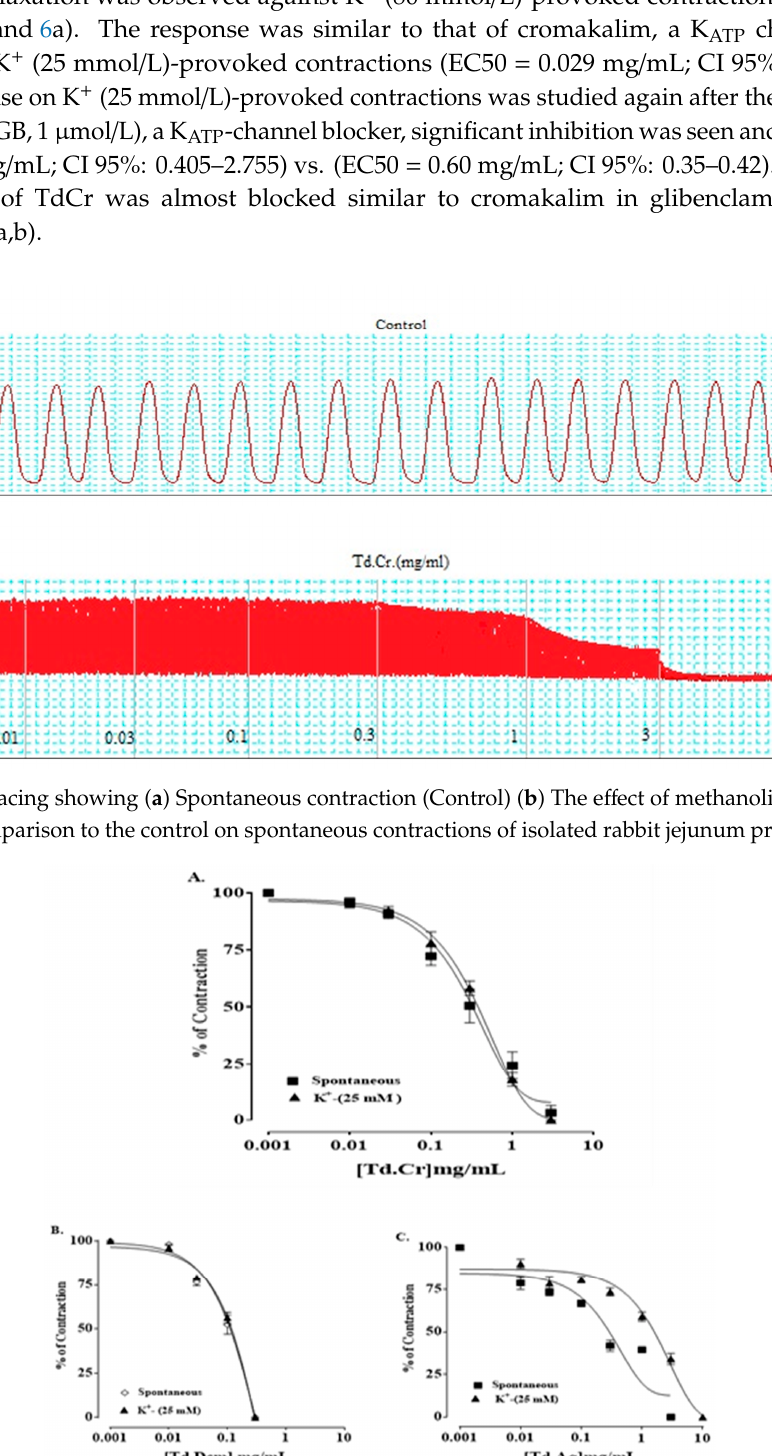
Figure 2. Bar graph representing the antidiarrheal activity of TdCr by a castor-oil-provoked method in rats. Bars express mean ± SEM with n = 6, analyzed by using ANOVA (one-way) and multiple